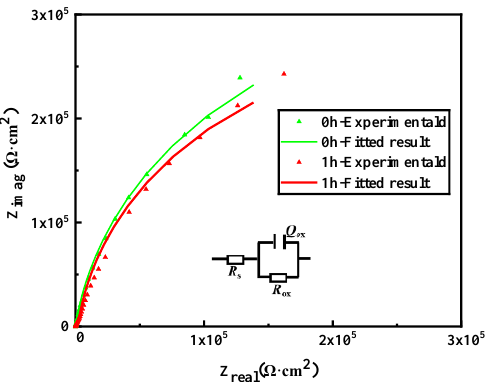
Figure 6. EIS results and the corresponding EC of TC4 alloy before and after hydrogen charging for 1 h in 3.5 wt.% NaCl solution.